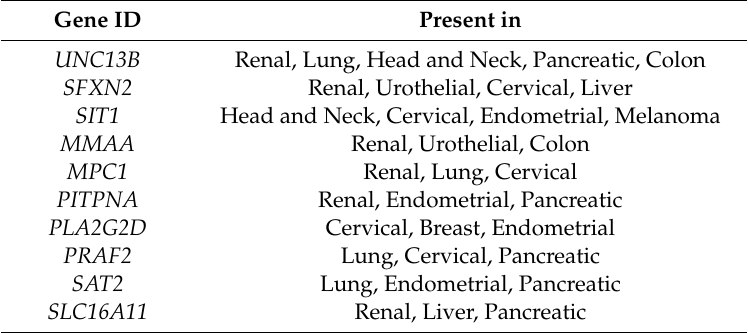
Table 3. Top ten favorable organic anion transporters common between different tumor entities. Gene Gene ID Present In UNC13B